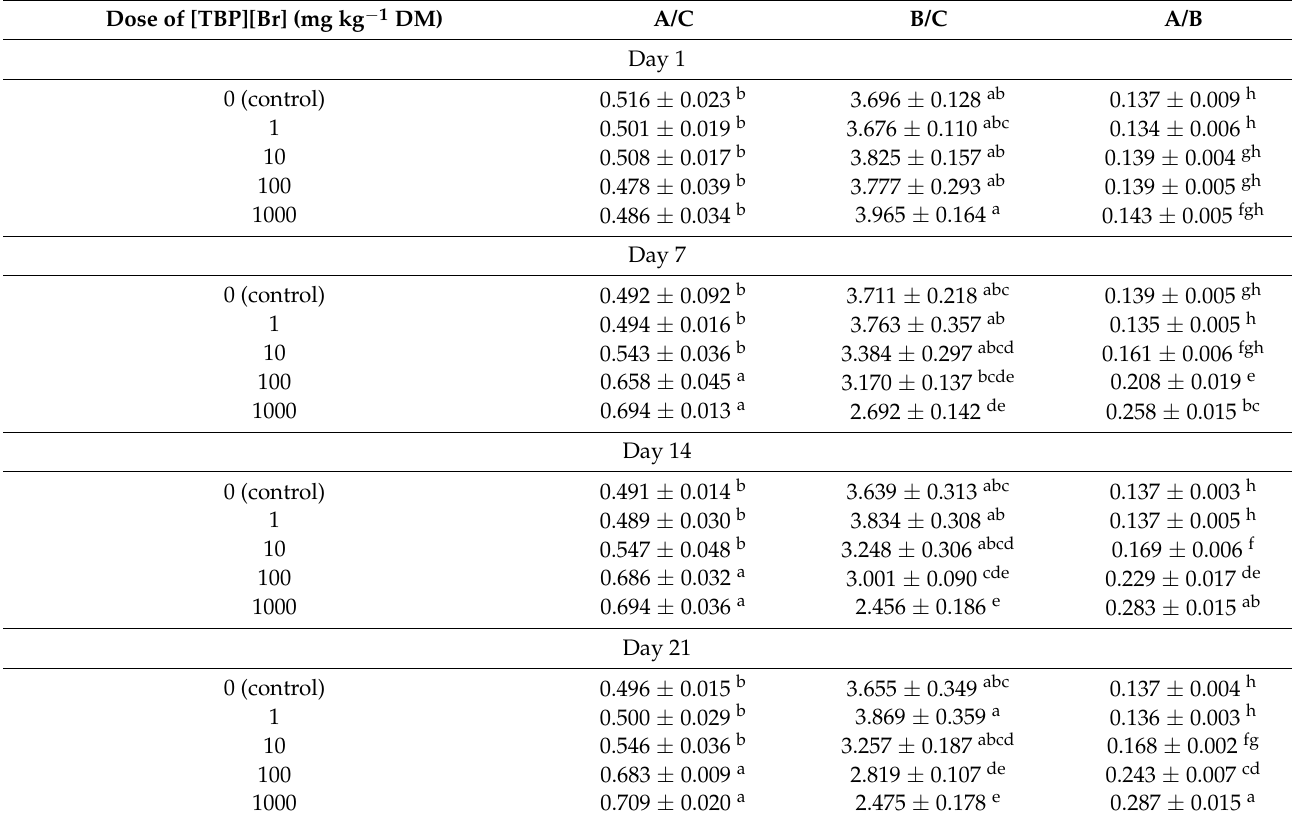
Table 4. Integration of absorption peaks corresponding to the aliphatic and hydrophilic SOM fractions in the soil exposed to tetrabutylphosphonium bromide [TBP][Br] in pot experiment with spring